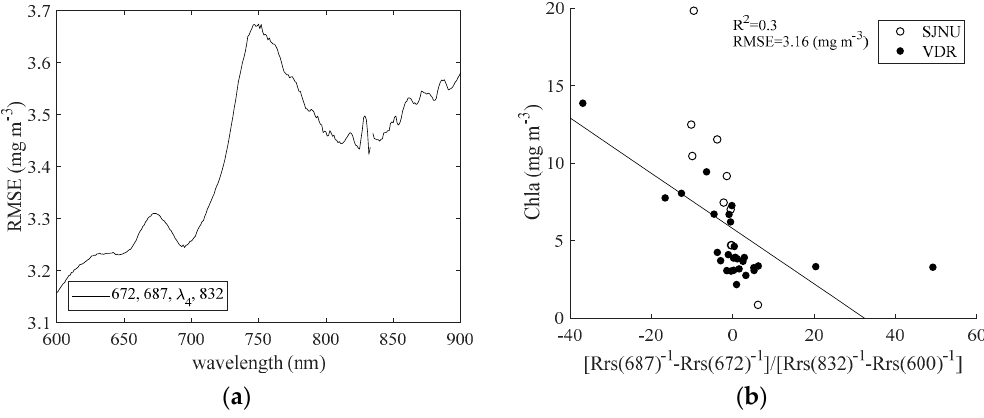
Figure 6. Chlorophyll a (Chla) results of the four-band model (C3) in Lake Shinji and Lake Nakaumi (SJNU) and the Vaal Dam Reservoir (VDR). ( a ) Root mean square error (RMSE) variation between [ R rs − 1 (687) − R rs − 1 (672)] × [R( λ 4 ) − R(832)] and measured Chla when λ 4 is moved in the 600–900-nm range; ( b ) optimal correlation between [ R rs − 1 (687) − R rs − 1 (672)] × [R − 1 (600) − R − 1 (832)] and measured Chla.